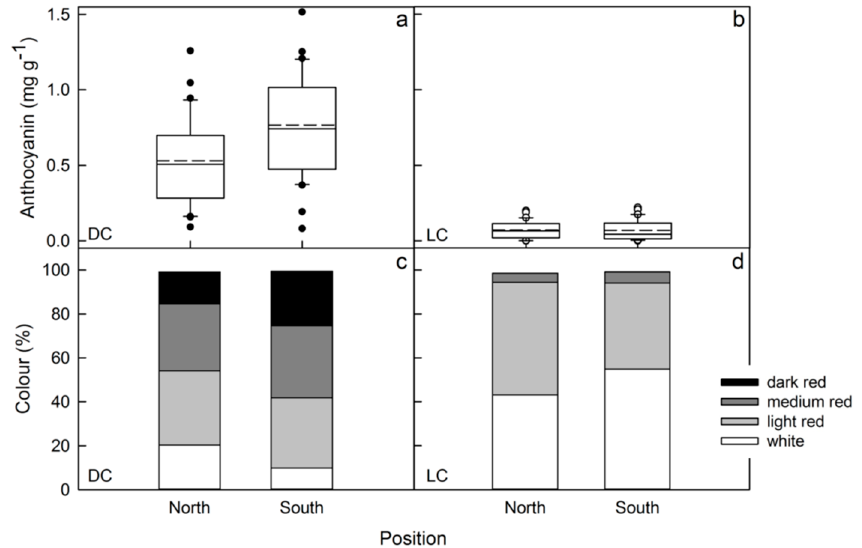
Figure 5. E ff ects of the exposure of the fruit to the sun on flesh anthocyanin content ( a , b ) and the color distribution ( c , d ) of red flesh apples of a dark-colored (DC) ( a , c ) and a light-colored (LC) clone ( b , d ). The intensity of flesh color decreased when branches were shaded with hail net (Figure 6a,b). UV-exposure did not a ff ect flesh color in the DC clone (Figure 7a,c) but in the LC clone flesh color decreased significantly when fruit were covered with UV-absorbing film (Figure